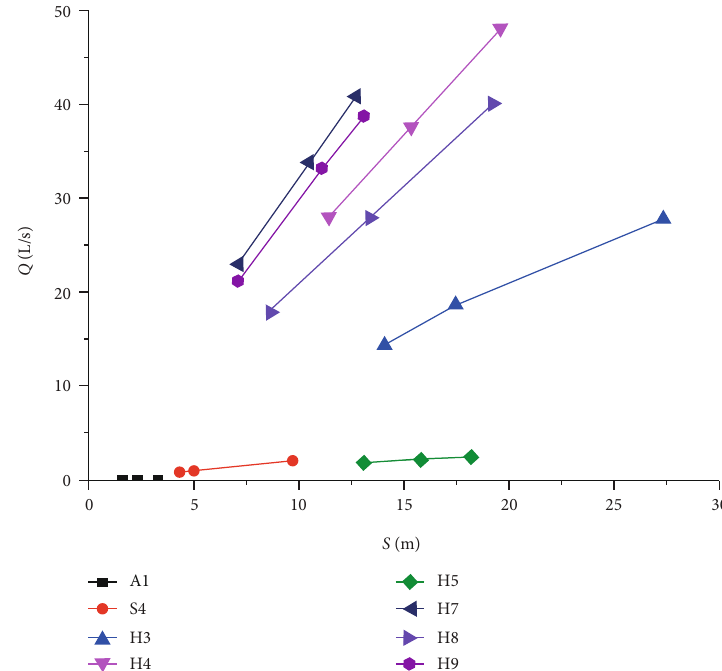
Figure 7: Q ‐ S curve of water pumping experiment.